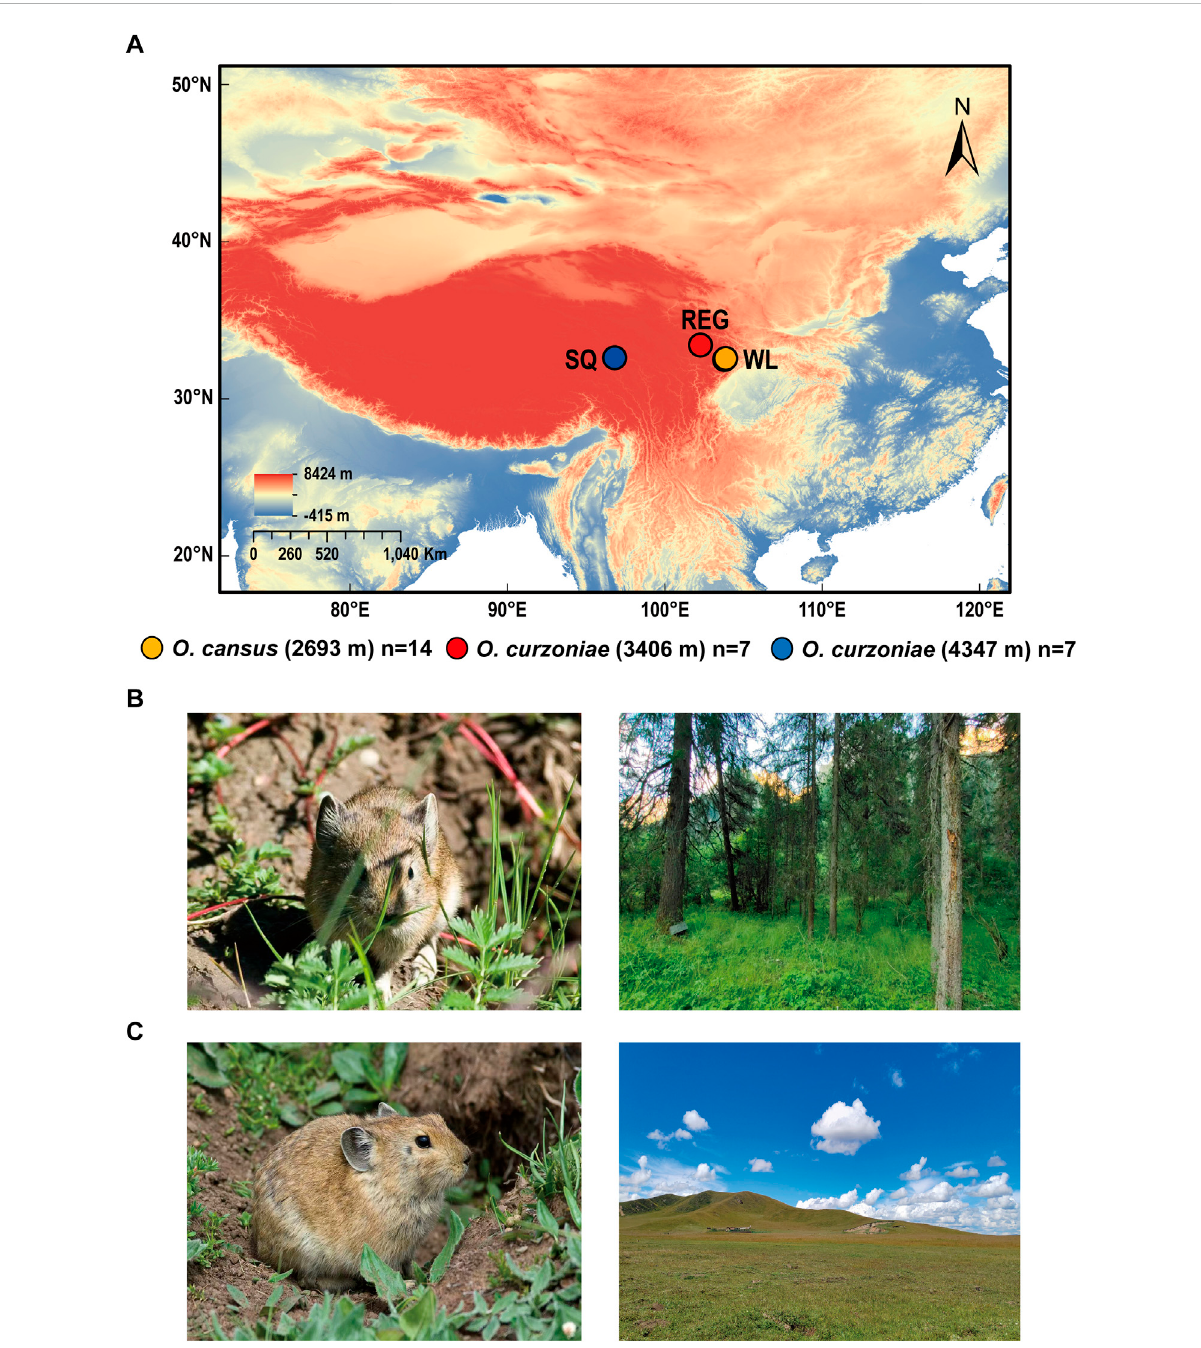
FIGURE 1 Diagram ofpika sample collectionsites. (A) Collection ofpikasamplesatWL, REG andSQ. (B) O . cansus (FromAndrey Lissovsky) and collection site in the Wanglang National Nature Reserve (From Danping Mu). (C) O. curzoniae (From Andrey Lissovsky) and collection site in the Zoige Wetland National Nature Reserve (From Danping